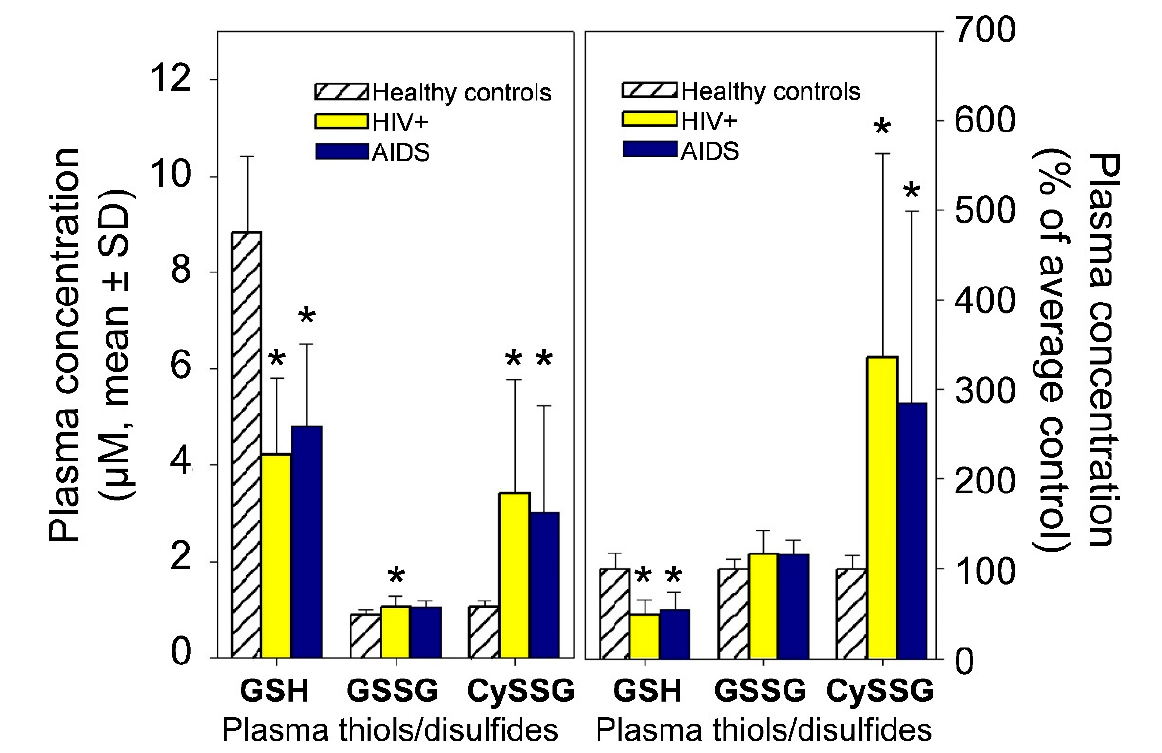
Figure 2. Plasma GSH, GSSG, and CySSG in 10 healthy (HIV-negative) people, 30 HIV-positive, and 23 AIDS patients. ( Left ) Derived from Figure 1 and the text of Walmsley et al. [15]. ( Right ) the same data plotted as per cent of average healthy controls. * p < 0.05 compared to controls.